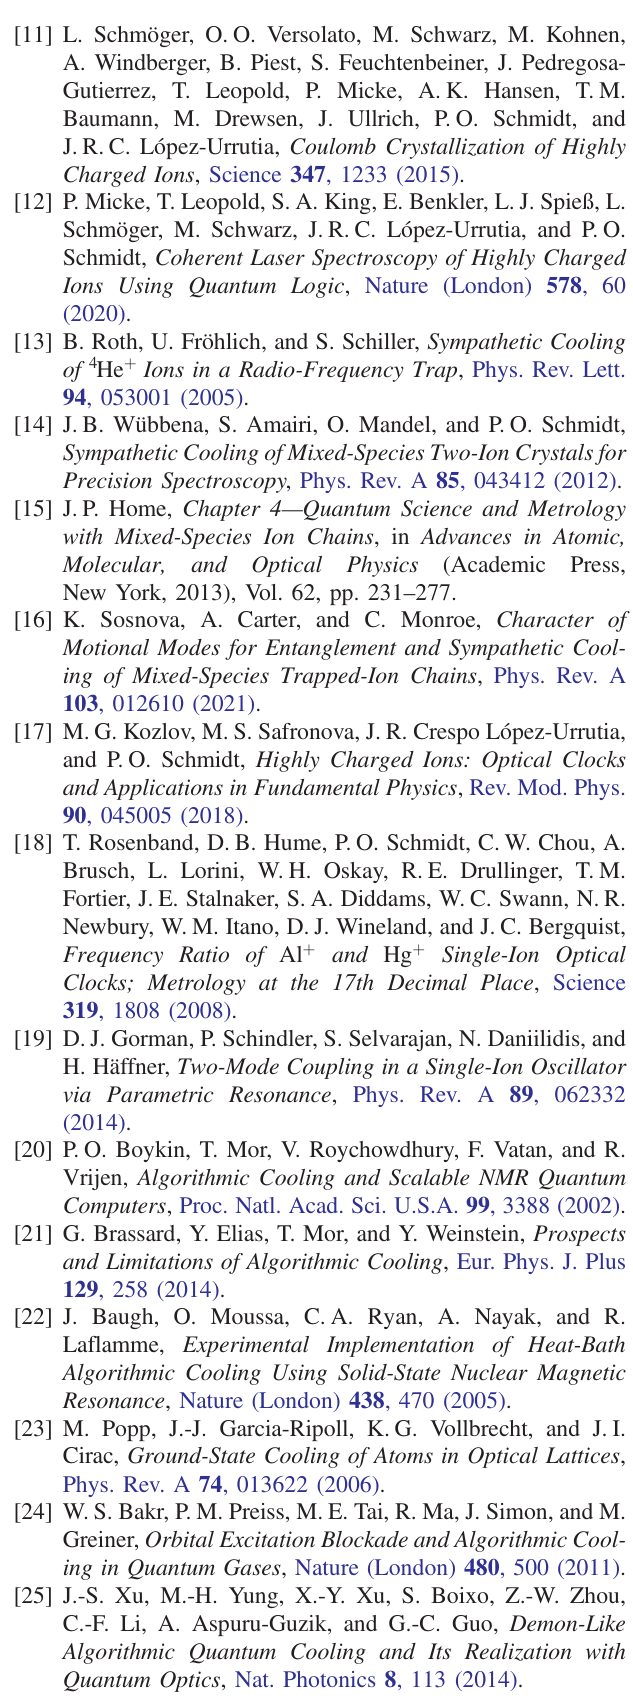
ALGORITHMIC GROUND-STATE COOLING OF